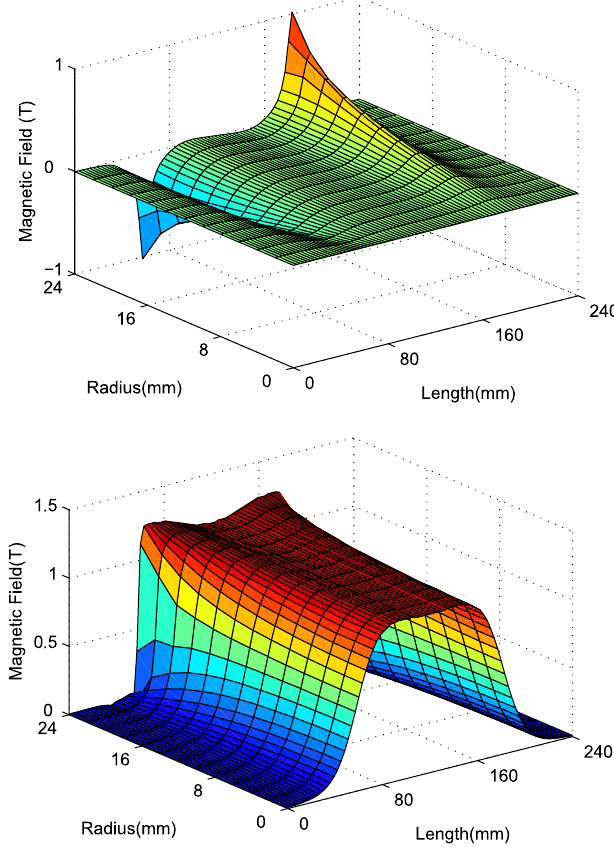
FIG. 5. (Color) 3D magnetic fields used in simulations. Top: radial magnetic field. Bottom: longitudinal magnetic